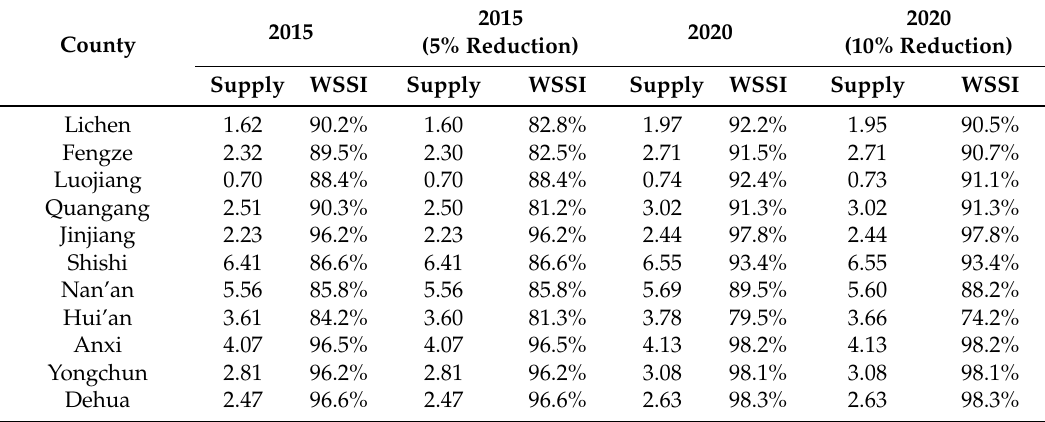
Table 3. Average water supply and WSSI of counties after the long-series optimal